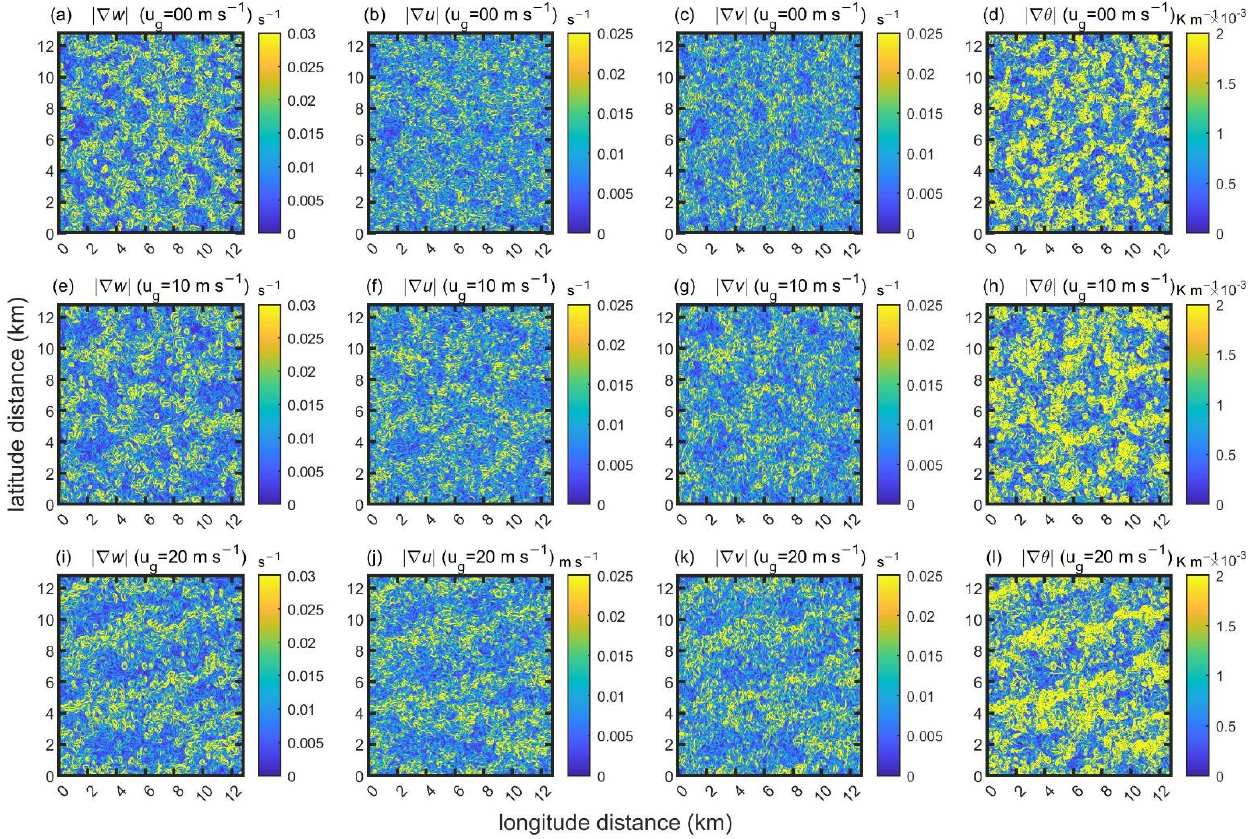
Figure 3. Instantaneous snapshots of w ’s gradient magnitude ( |∇𝑤| , the first column ), u ’s gradient magnitude ( |∇𝑢| , second column ), v ’s gradient magnitude ( |∇𝑣| , the third column ), and θ’s gradient magnitude ( |∇𝜃| , the last column) from LES simulations at z / z i = 0.5 at 3 h of physical time across the range of U g . First row U g = 0 ms −1 ; second row U g = 10 ms −1 ; third row U g = 20 ms −1 . Note that the color scales of |∇𝑤| , |∇𝑢| , |∇𝑣| , and |∇𝜃| are adjusted separately for clarity and contrast.